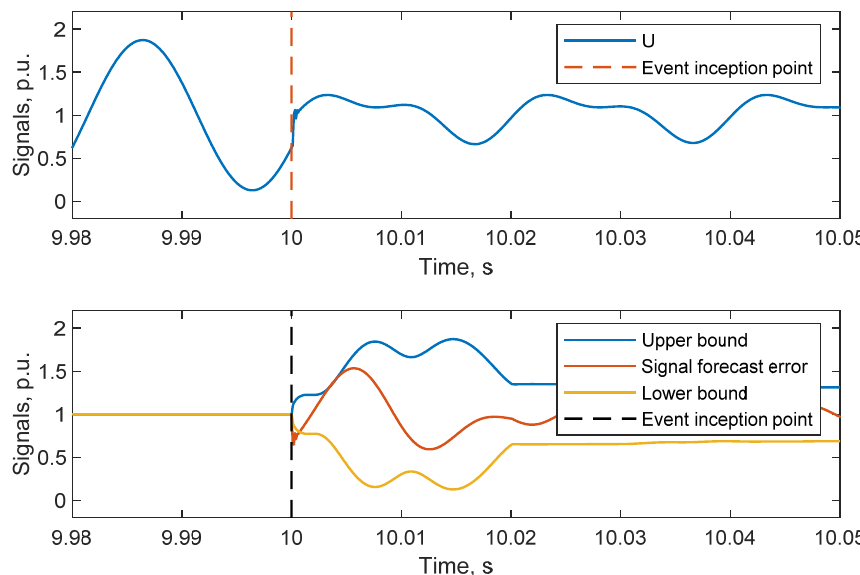
Figure 8. The result of disturbance inception detection.